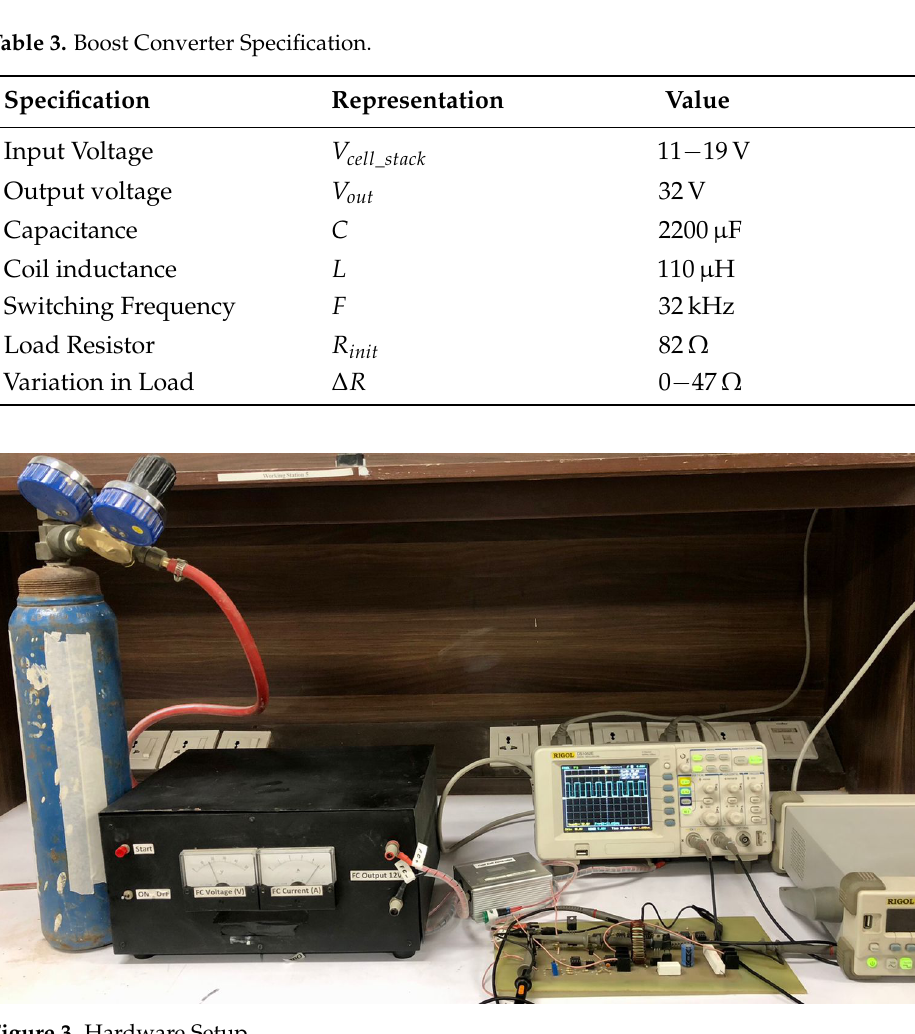
Figure 3. Hardware